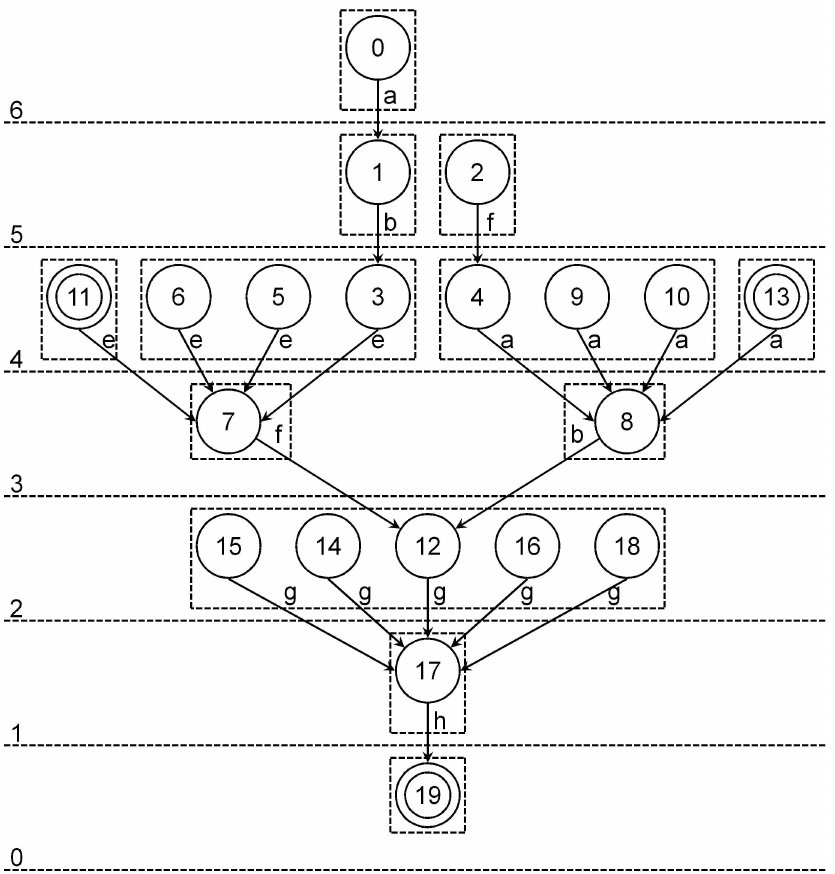
Fig 4. Backward depth information for accepted state “19” in Table 1. The number above the dashed line represents the backwarddepth, and the states in the same dashed box are in one block. The symbol near the transition is the character consumed in buildingthe shortest path from the state transition graph, and is one part of the backwarddepth information.